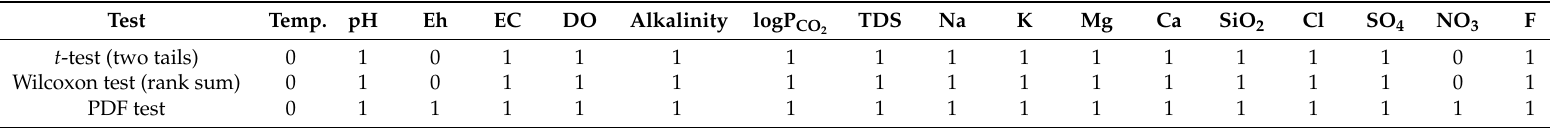
Table 5. Result of comparing PDF test with t -test and Wilcoxon test in Gangwon Province (0 means acceptance = no difference; 1 means rejection =